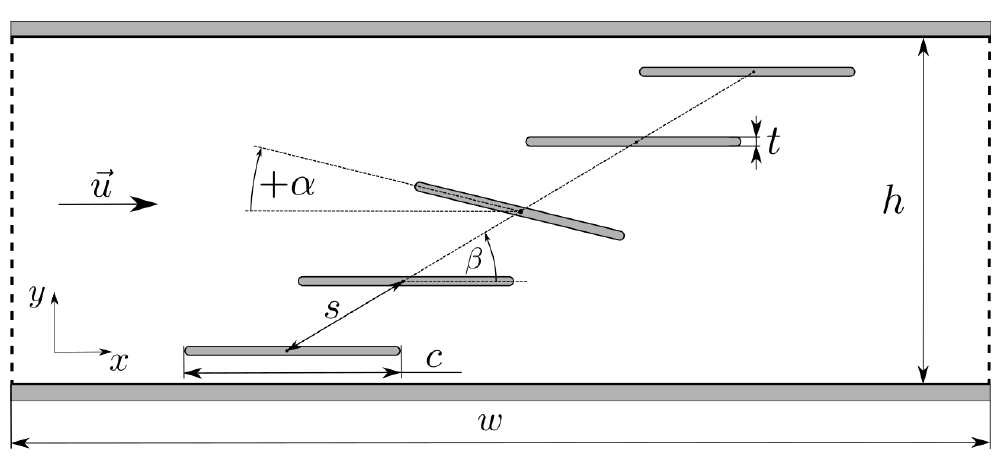
Figure 1. Geometry of the